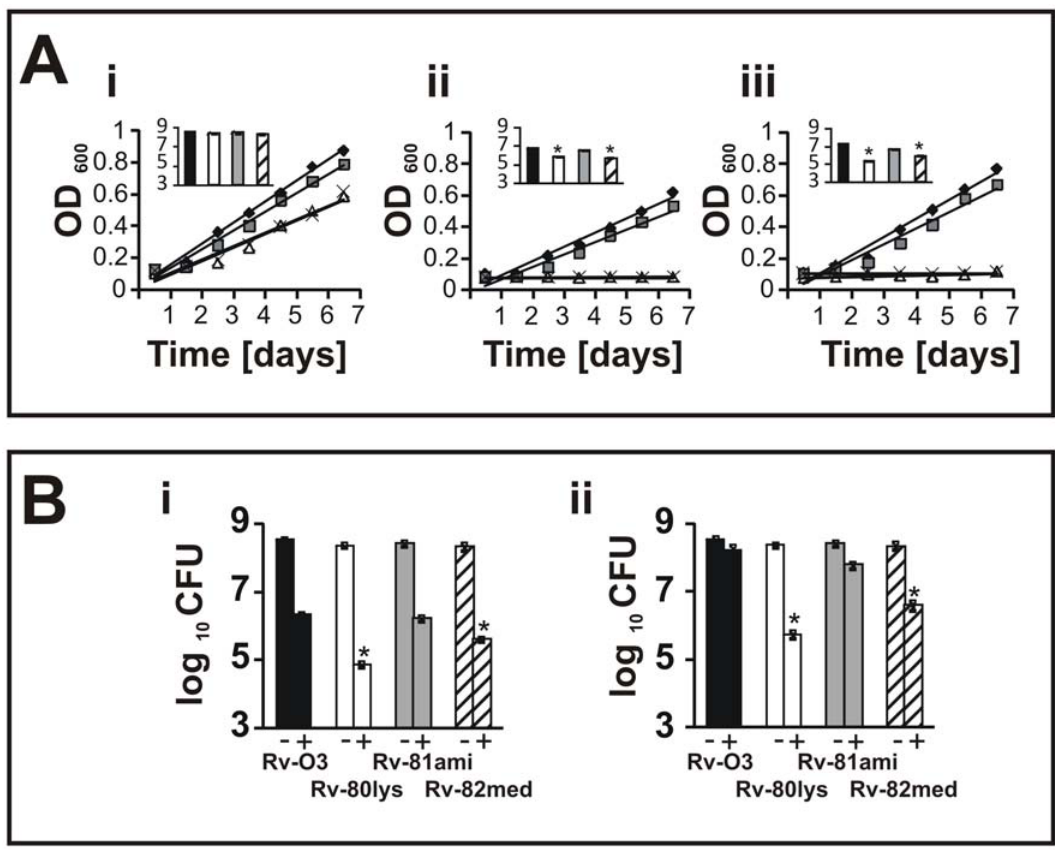
Figure 3. Phenotype of lysX strains. Panel A: The growth and viability of the Mtb lysX strains in 7H9 broth in the absence of antibiotics -i . A-ii: The growth and viability of cultures grown in the presence of 1.0 m g/ml Van. At the indicated times, growth was measured. After 3 days of growth in broth, viability was determined by plating cells on Middlebrook 7H11 agar and determining the CFU. Symbols: Filled diamonds – Rv-03; grey squares – Rv81-ami; white triangles – Rv-80lys; crosses – Rv-82med. The inset shows the viable cell count. Black bars - Rv-03, grey bars - Rv-81ami, white bars - Rv-80lys and dashed bars - Rv82-med. A-iii: The growth and viability of cultures grown in the presence of 100 units/ml PMB. * Represents a P value , 0.001 versus Rv-03 and Rv-81ami (Student-Newman-Keuls Method); bars represent means 6 standard error. Panel B: The growth and viability of Mtb strains in the presence of 1 mg/ml lysozyme -i- or HNP-1 -ii . There was no significant reduction in viability compared to cultures grown without TFA (data not shown). The stars represent P , 0.001 versus Rv-03 and Rv-81ami (Student-Newman-Keuls Method). The bars represent the mean 6 standard error. doi:10.1371/journal.ppat.1000534.g003 the Rv-80lys cells was determined using a slow-response membrane potential-sensitive dye, DiOC 2 (3), and comparing with Rv-03 cells. This cationic cyanine dye exhibits green fluorescence ( Ex = 488 nm and Em = 520 nm) in the monomeric state and red fluorescence ( Ex = 488 nm and Em =620 nm) in the aggregated or oligomeric state. As a negative control, the membrane potential was measured following exposure of the cells to the proton ionophore m -chlorophenylhydrazone (CCCP), which is known to eliminate the proton gradient across the membrane. As seen in Figure 4, the membrane potentials (measured as the ratio of red to green fluorescence) of the lysX mutant Rv-80lys and Rv-82med were 21% and 17%, respectively, higher than that of the Rv-03 and complemented Rv-81ami ( P , 0.002). The increased ratio of red to green fluorescence observed in lysX mutants suggests accumulation of the positively charged lipophilic dye on the negatively charged membrane. The red to green fluorescence ratio in all strains was decreased to similar levels ( , 41%) in the presence of CCCP ( P = 0.001). Presumably, this reduction reflects the completely depolarized state of the membrane. Together, these results indicate that the membranes of Rv-80lys and Rv-82med are hyperpolarized relative to Rv-03 and Rv-81ami.